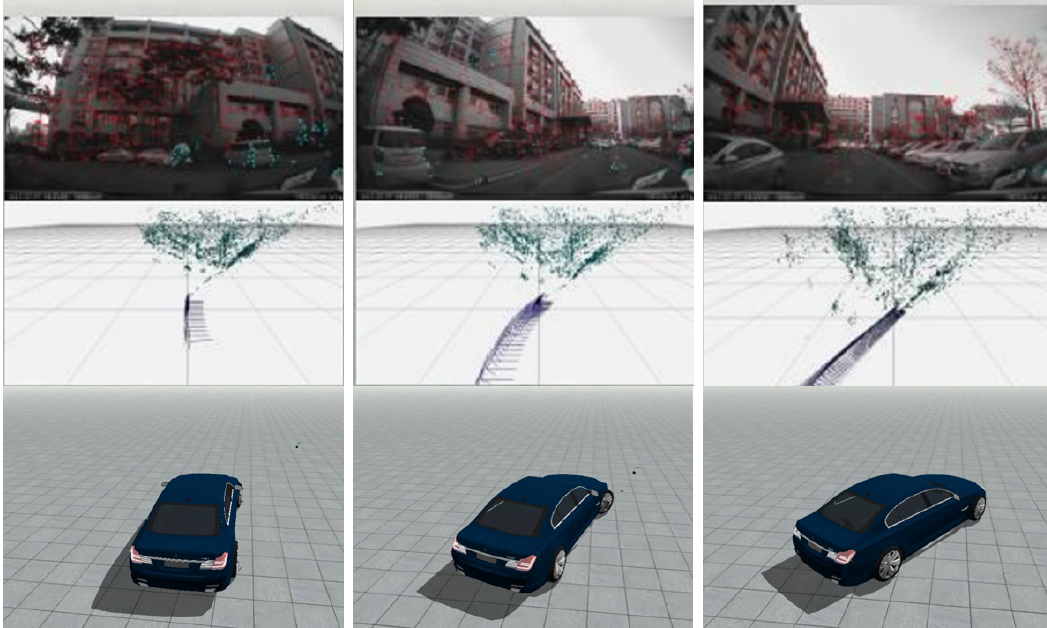
Figure 16. Input trajectory estimated from GPS data extracted from dashboard